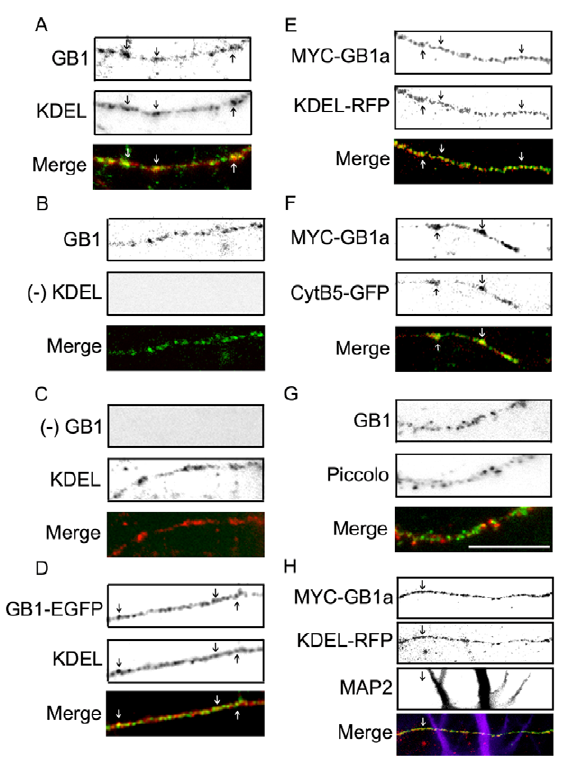
Figure 2. GABA B R1a colocalizes with the ER in axons. ( A ) Representative axon of hippocampal neurons processed for immuno- fluorescence under permeabilized conditions. GABA B R1 was detected with GABA B R1 antibodies (GB1, green) and the ER was detected with KDEL antibodies (KDEL, red). Merged images are shown on the bottom panel (representative image of n=17 neurons). ( B ) Same as above excluding staining with primary KDEL antibodies. ( C ) Same as above excluding staining with primary GABA B R1 antibodies. ( D ) Representa- tive axon of hippocampal neurons from GABA B R1-EGFP mice processed for immunofluorescence under permeabilized conditions. GABA B R1- EGFP signal was amplified with EGFP antibodies (GB1-EGFP, green) and the ER was detected with KDEL antibodies (KDEL, red). Merged images are shown on the bottom panel (representative image of n=10 neurons). ( E ) Representative axon of hippocampal neurons transfected with MYC-GABA B R1a and KDEL-RFP and processed for immunofluores- cence under permeabilized conditions. MYC-GABA B R1a was detected with MYC antibodies (MYC-GB1a, green), KDEL-RFP was visualized without staining (red). Merged images are shown on the bottom panel (representative image of n=20 neurons). ( F ) Representative axon of hippocampal neurons transfected with MYC-GABA B R1a and cyto- chrome b5-EGFP (CytB5-GFP) and processed for immunofluorescence under permeabilized conditions. MYC-GABA B R1a was detected with MYC antibodies (MYC-GB1a, green), CytB5-GFP was visualized without staining (red). Merged images are shown on the bottom panel (representative image of n=20 neurons). ( G ) Representative axon of hippocampal neurons processed for immunofluorescence under permeabilized conditions. GABA B R1a was detected with GABA B R1 antibodies (green) and Piccolo was detected with Piccolo antibodies (red). Merged images are shown on the bottom panel (representative image of n=15 neurons). ( H ) Representative axon of hippocampal neurons transfected with MYC-GABA B R1a and KDEL-RFP and processed for immunofluorescence under permeabilized conditions. MYC-GABA- B R1a was detected with MYC antibodies (MYC-GB1a, green), KDEL-RFP was visualized without staining (red) and MAP2 was detected with anti- MAP2 antibodies (MAP2, magenta). The axon is identified as a MAP2- negative projection. Merged images are shown on the bottom panel (representative image of n=15 neurons). Scale bar for A-H represents 20 m